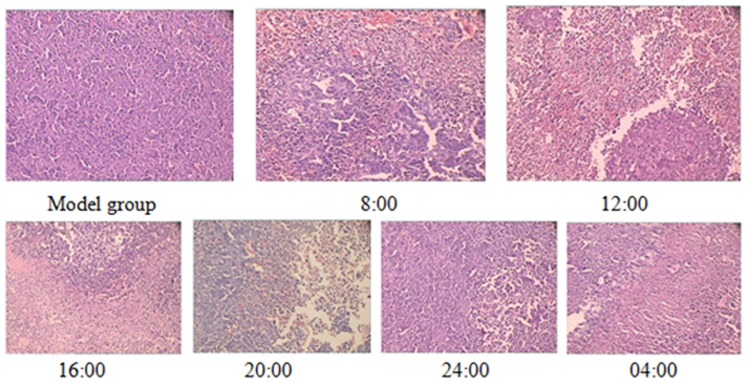
Microscopic images of pathological observation of tumors formed three weeks after the inoculation of lewis lung carcinoma cells into C57BL/6 mice (HE staining, original magnification ×200).(Model group): Pathological section from the model group treated with distilled water. The tumor cells were poorly differentiated and arranged tightly, with abundant vessels around them. No obvious tumor cell necrosis could be observed and the boundary was extremely clear. (Groups 8:00, 12:00, 16:00, 20:00): Pathological section from the groups 8:00, 12:00, 16:00 and 20:00 after erlotinib administration. The tumor cells were poorly differentiated and arranged irregularly, with few new vessels around them. Large areas of necrosis, and inflammatory cell infiltration and bleeding were observed. (Groups 24:00 and 04:00): Pathological section from the groups 24:00 and 04:00 given erlotinib at 24:00 and 04:00. Small focal necrosis and inflammatory cell infiltration were observed.